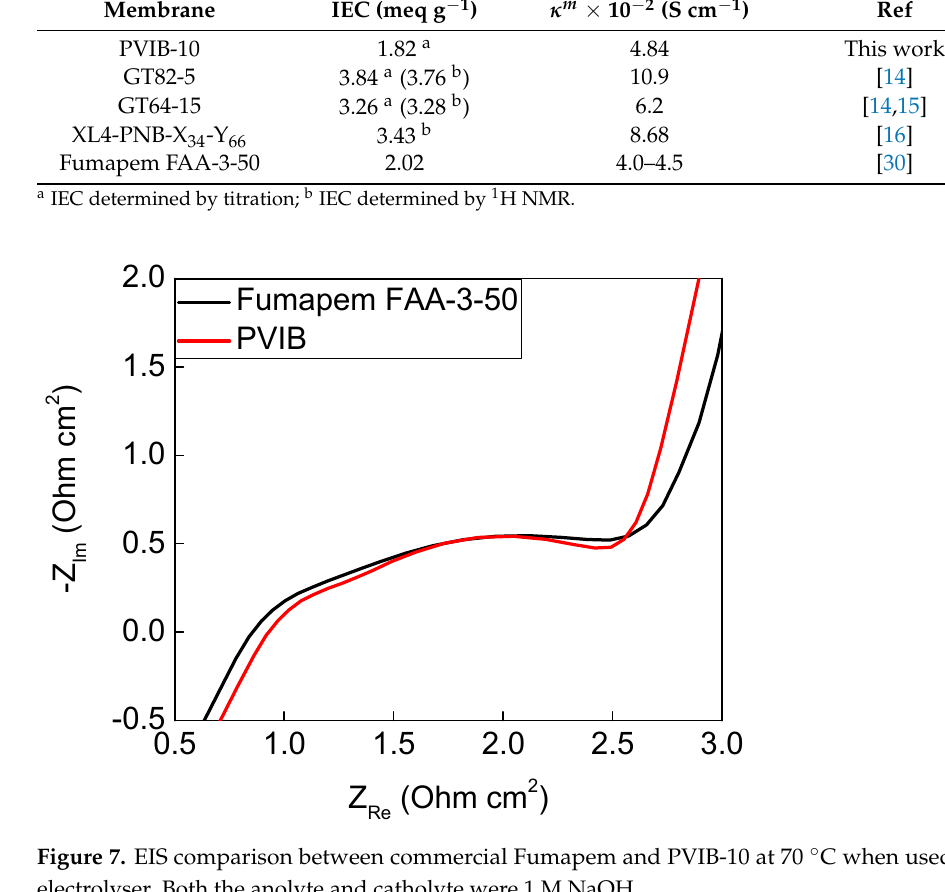
cially evident at the top left of the active area (highlighted with the-dashed rectangle)